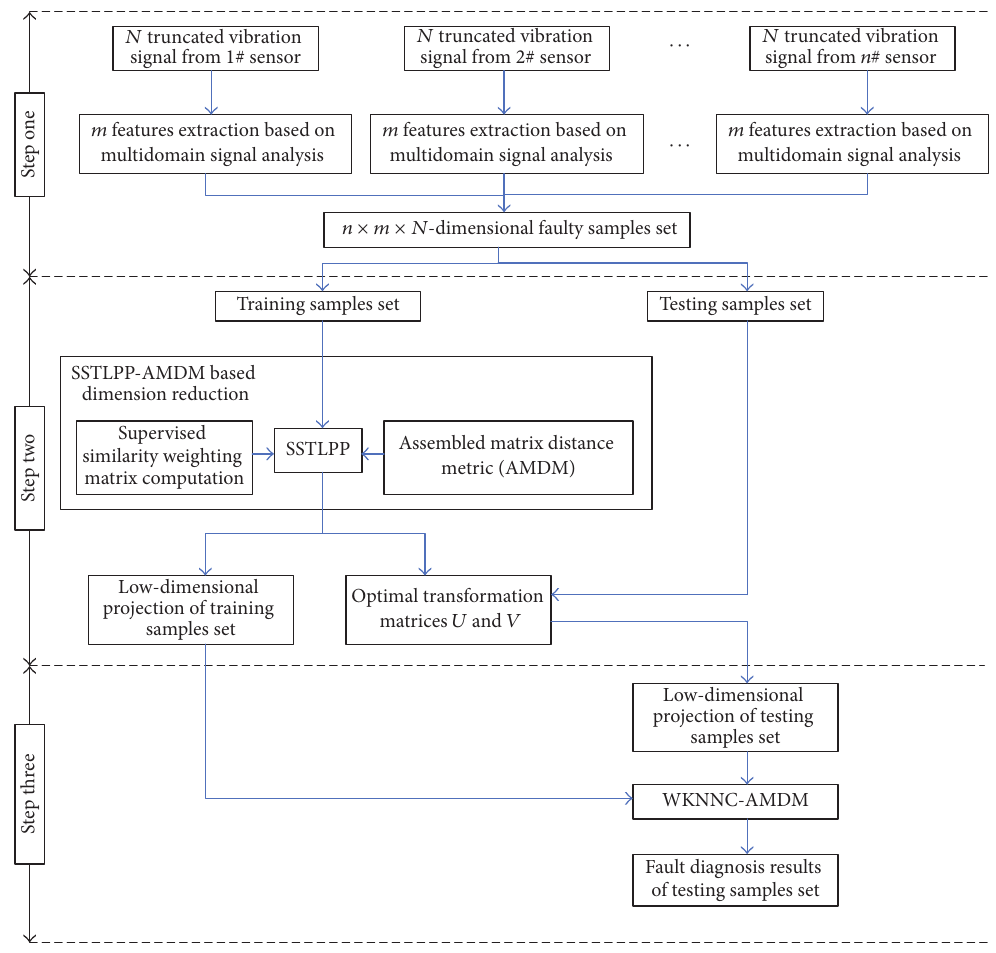
Figure 1: Implementation process of the proposed fault diagnosis method based on SSTLPP and WKNNC.